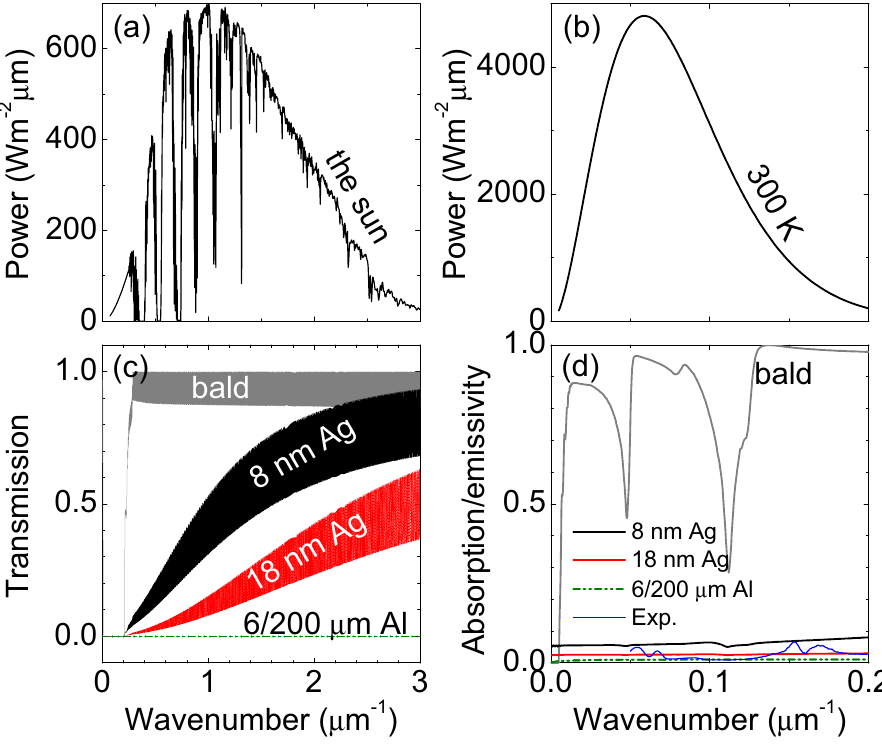
Figure 2. Optical and infrared properties of common low-e materials. ( a ) The air mass 1.5 direct normal and circumsolar spectrum. ( b ) Radiant power of the surface of a blackbody at temperature T = 300 K. ( c ) Calculated transmission and ( d ) absorption/emissivity of five pieces of 1 mm-thick glass that are bald (grey line), 8 nm- thick-Ag coated (black line), 18 nm-thick-Ag coated (red line), and 6 or 200 μ m-thick-Al covered (green lines), respectively. The blue line in ( d ) is the measured spectrum for a piece of 1 mm-thick glass coated by 3-nm-thick TiO 2 , 1-nm-thick Au, 12-nm-thick Ag, 1-nm-thick Au and 100-nm-thick TiO 2